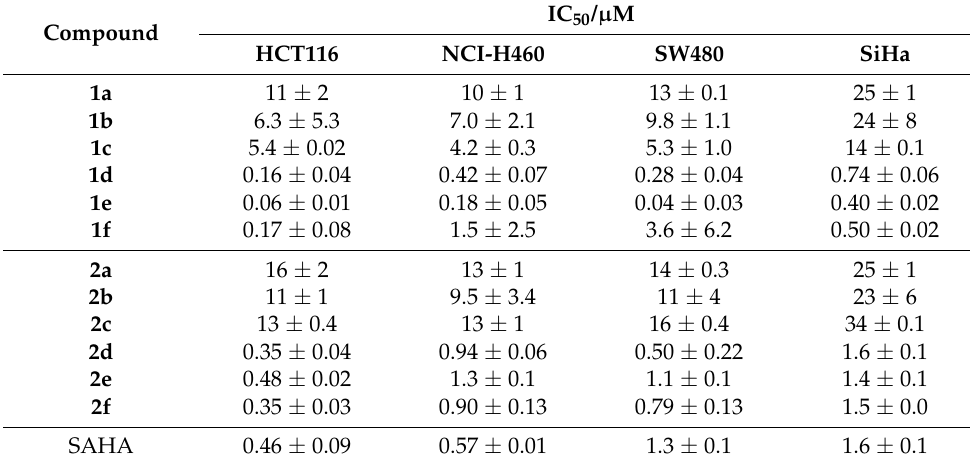
Table 1. 50% inhibitory concentration (IC 50 ) values of (thio)pyridones 1a – 1f and Ru complexes 2a – 2f following incubation for 72 h on human colorectal cancer (HCT116), non-small cell lung (NCI-H460), cervical (SiHa), and colon cancer (SW480) cell lines.